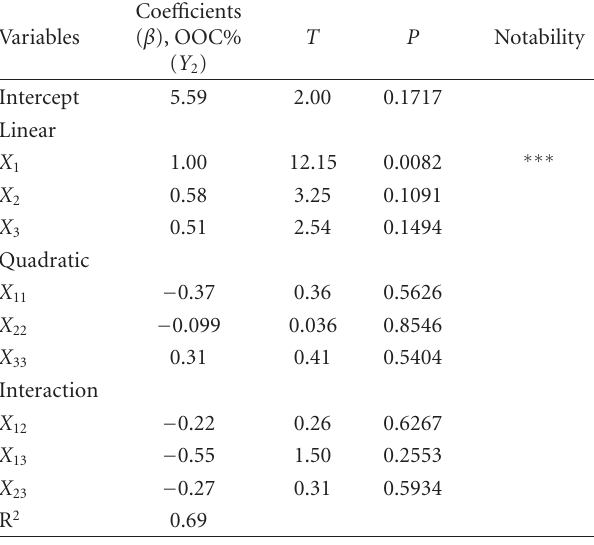
Table 3: Regression coe ffi cients of the predicted quadratic polyno- mial model for response variables of the yield% of MEOA.